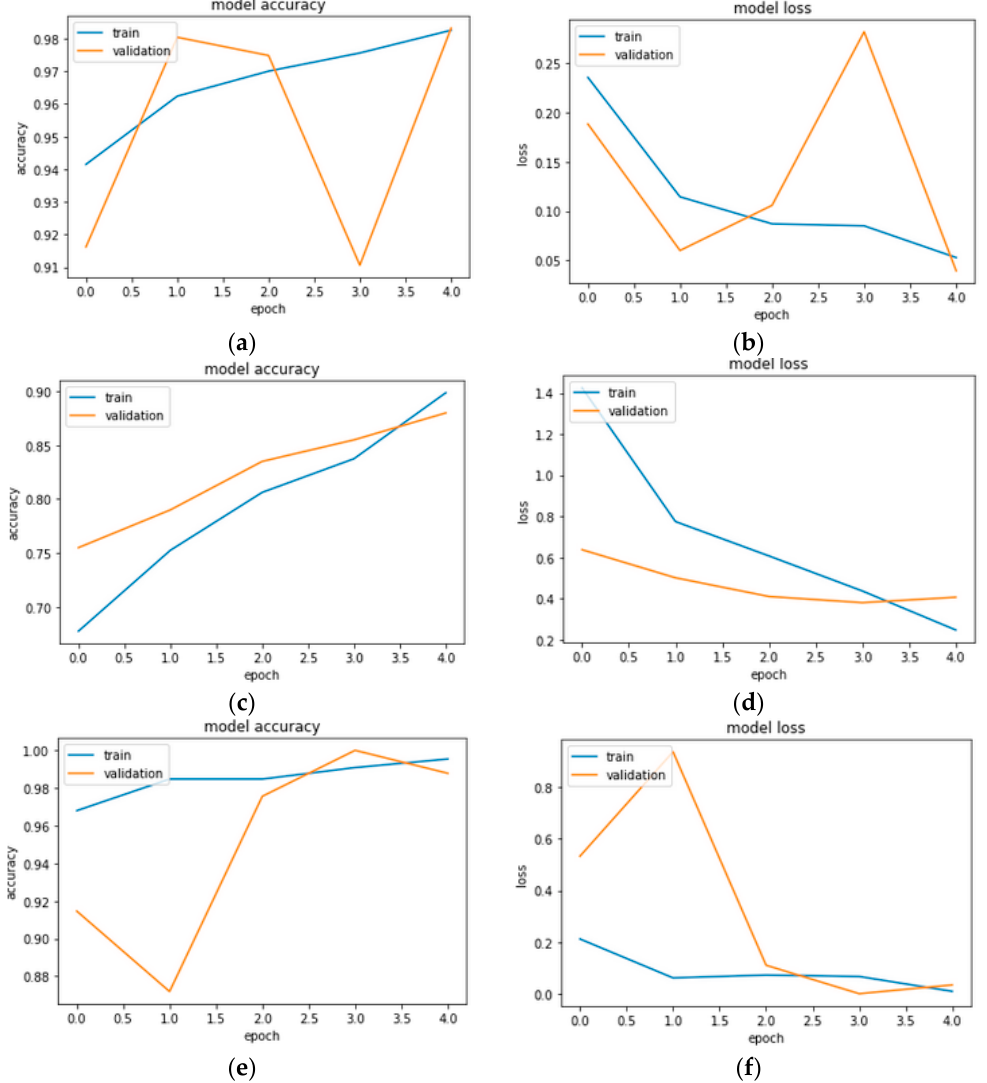
Figure 10. Validation and training analysis over five epochs of the pre-trained DenseNet121 model using various datasets: ( a ) validation and training model accuracy analysis, using the Clarkson 2015 dataset; ( b ) validation and training model loss analysis, using the Clarkson 2015 dataset; ( c ) validation and training model accuracy analysis, using the IIITD dataset; ( d ) validation and training model loss analysis, using the IIITD dataset; ( e ) validation and training model accuracy analysis, using the ND_Iris3D_2020 dataset; and ( f ) validation and training model loss analysis, using the ND_Iris3D_2020 dataset.